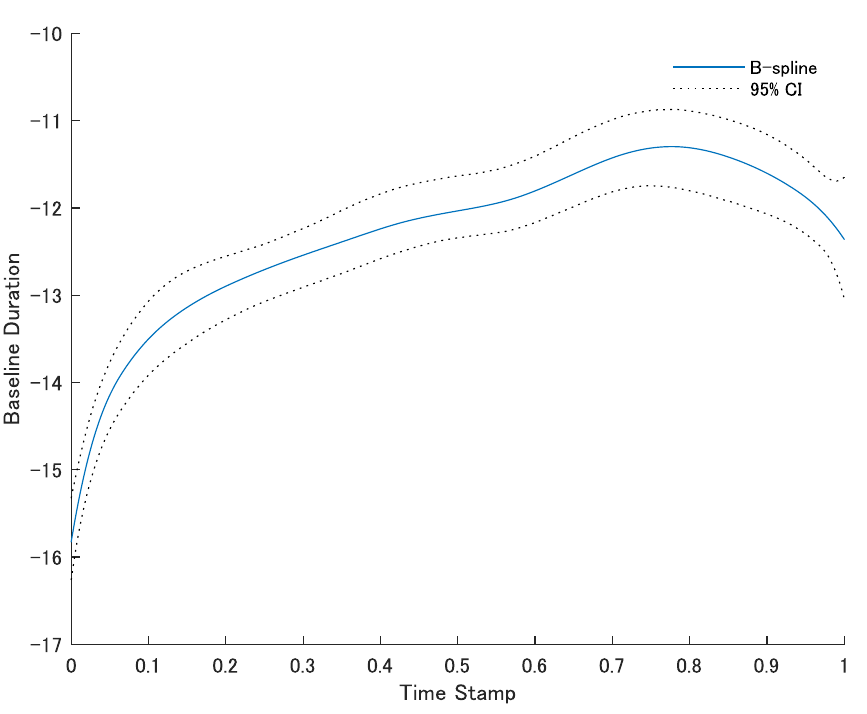
Figure 6. Intraday seasonality of time interval of AGH, Tokyo, Japan (27 July 2016).